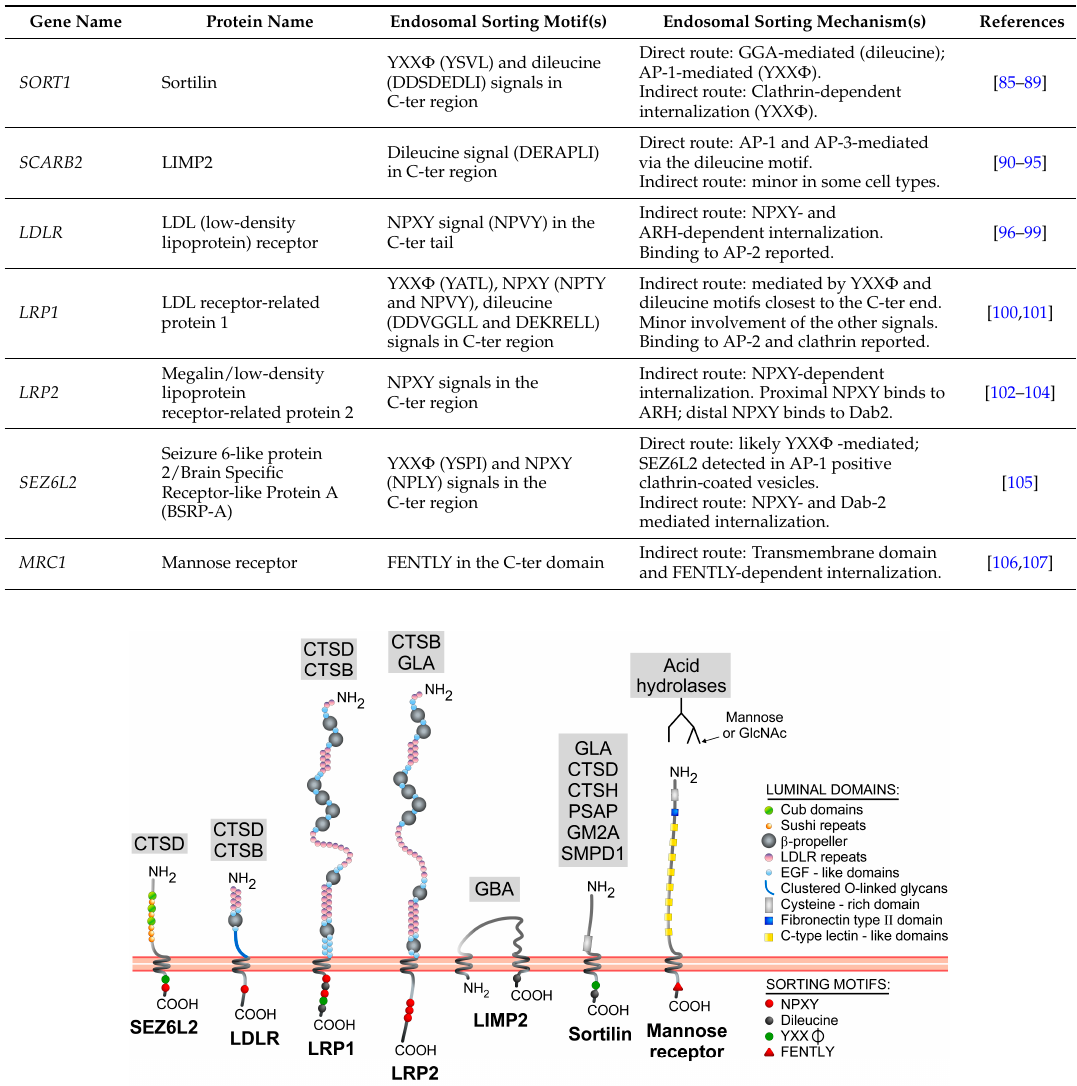
Table 2. Alternatives to the mannose 6-phosphate receptors.